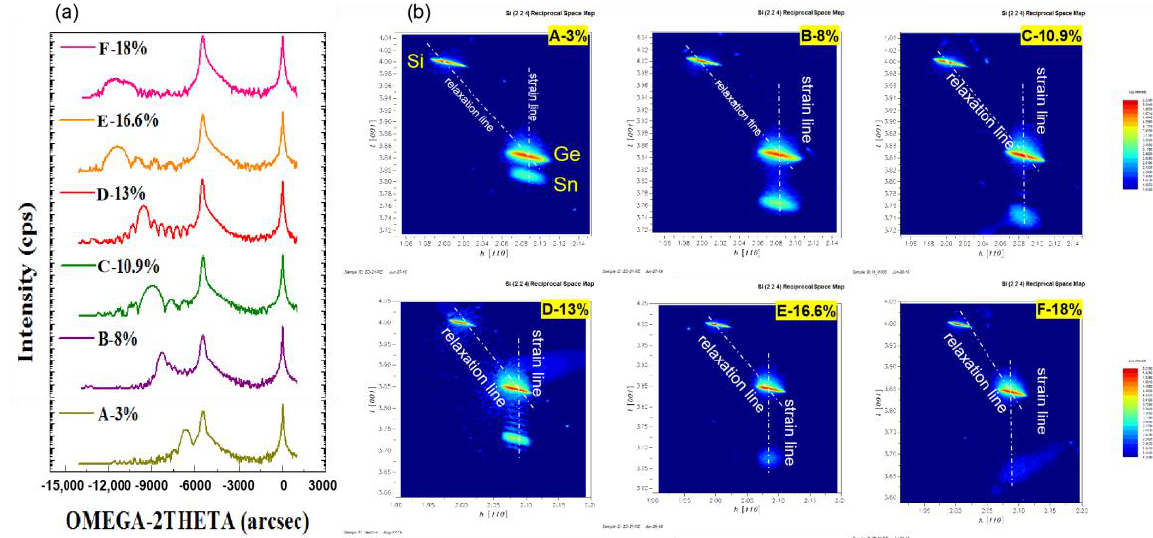
Figure 4. X-ray analysis of GeSn/Ge layers ( a ) rocking curves and ( b ) 224 HRRLMs.